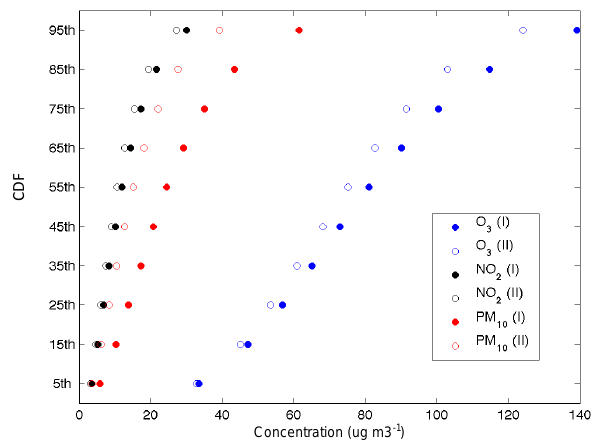
Figure 1. The cumulative density functions of the observations (O 3 , NO 2 , PM 10 ) in the two AQMEII phases (Phase I: filled circles, Phase II: unfilled circles). Each bullet represents the median at the specific